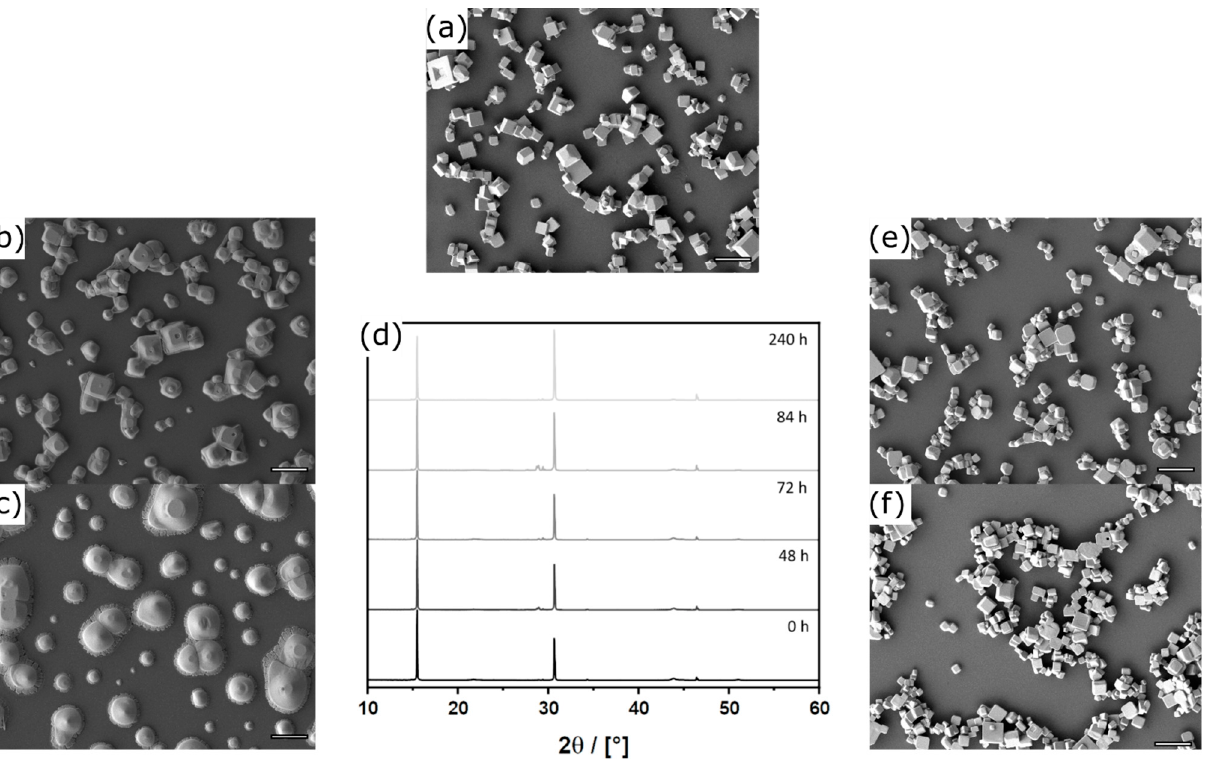
Figure 5. SEM micrographs (scale bars = 5 μ m) of the freshly prepared sample with a density of (a) CU-microcrystals. Storage under ambient conditions for (b) 48 h and (c) 240 h and (d) corresponding PXRD-patterns with dominant (100) and (200) reflexes. SEM micrographs for storage under dry conditions for (e) 48 h and (f) 96 h.